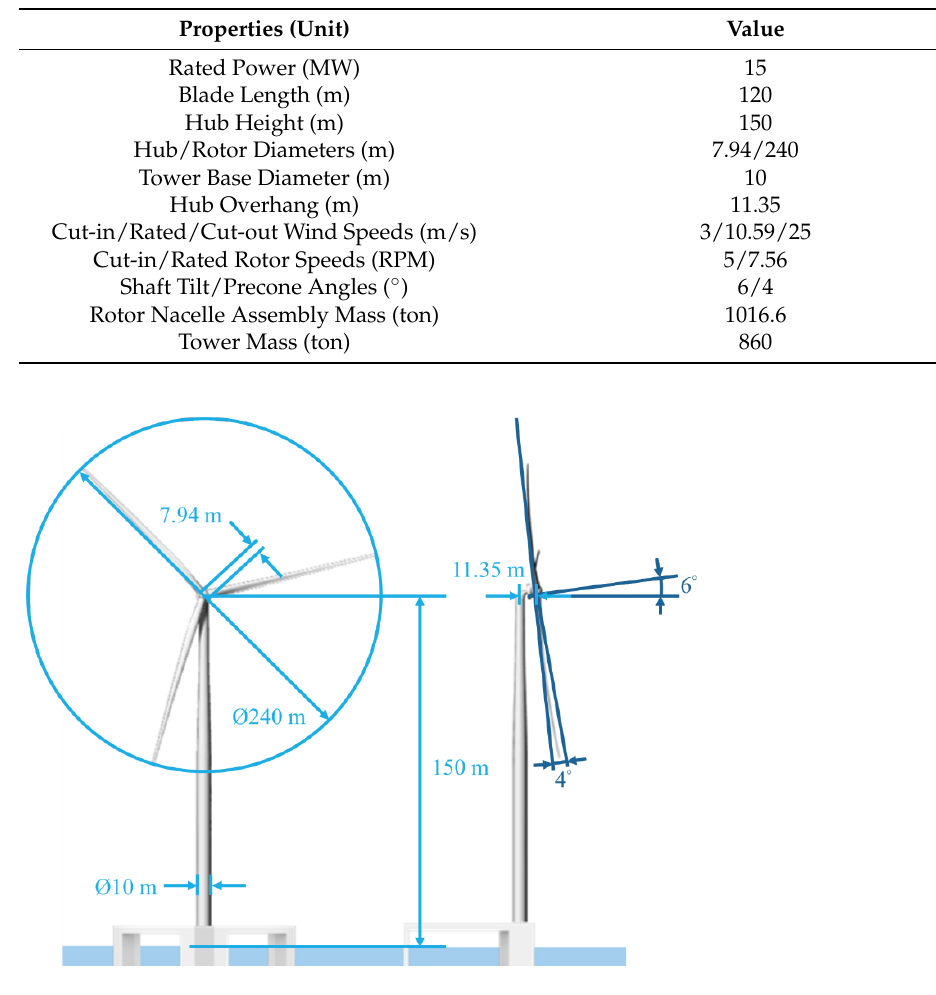
Figure 3. Dimensions of IEA 15 MW offshore wind turbine.